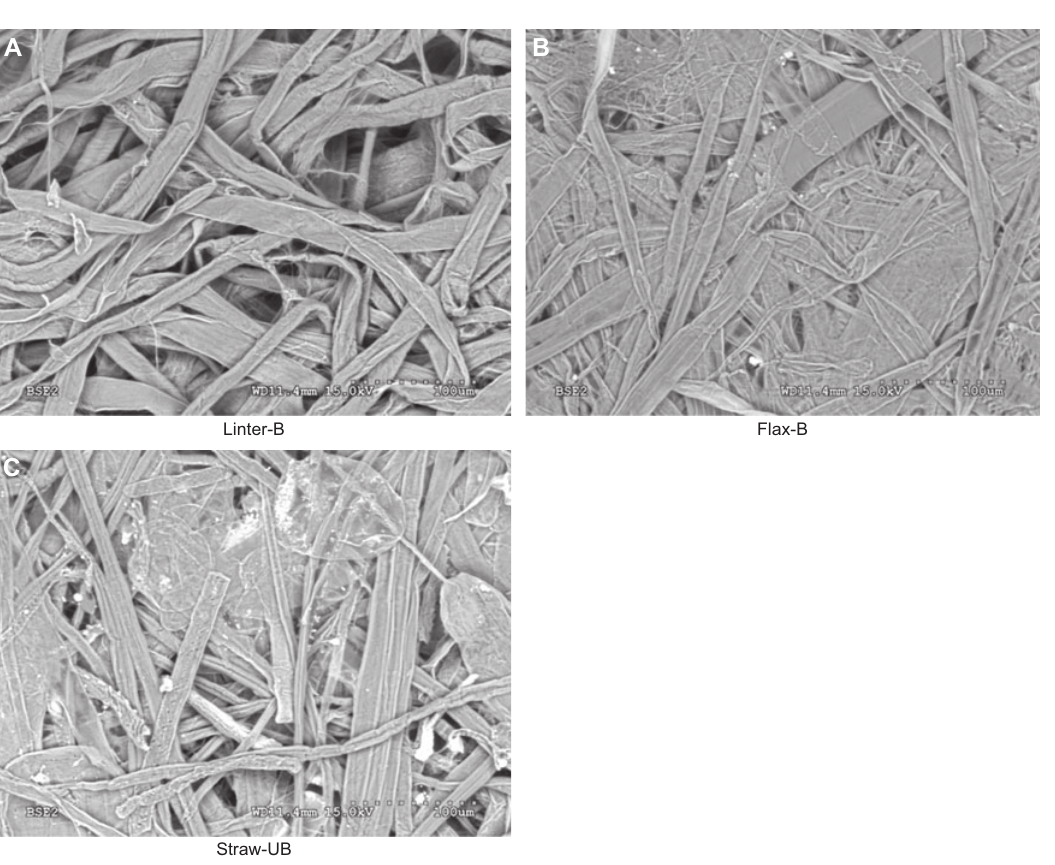
Figure 2 Scanning electron images of handsheets made from unbeaten different non-wood